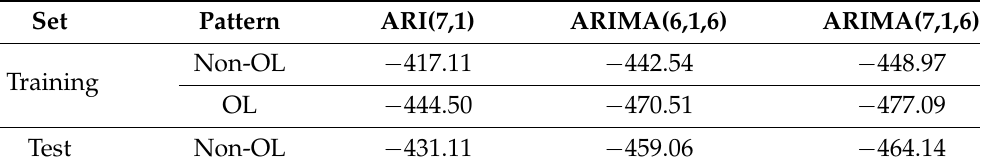
Table 3. Average AIC of the three candidate models.